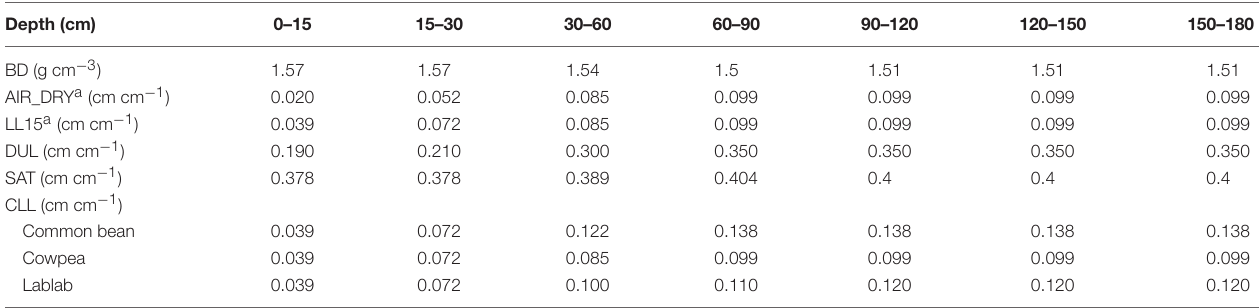
TABLE 3 | Layer soil type parameters used by APSIM-SOILWAT module: bulk density (BD), soil water content at air-dry (AIR_DRY), 1.5MPa tension (LL15), drained upper limit (DUL), saturation (SAT), and species-specific crop lower limit (CLL) at the experimental site KARI Katumani, Kenya. Depth (cm)